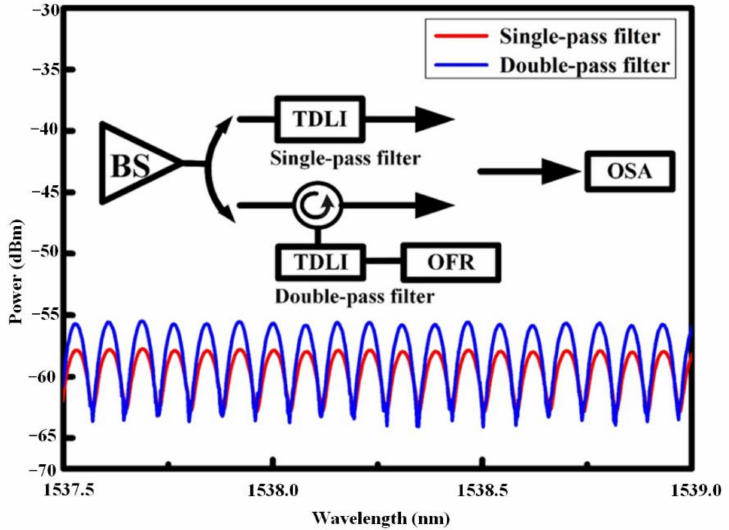
Figure 4. The broadband source with single-pass and double-pass